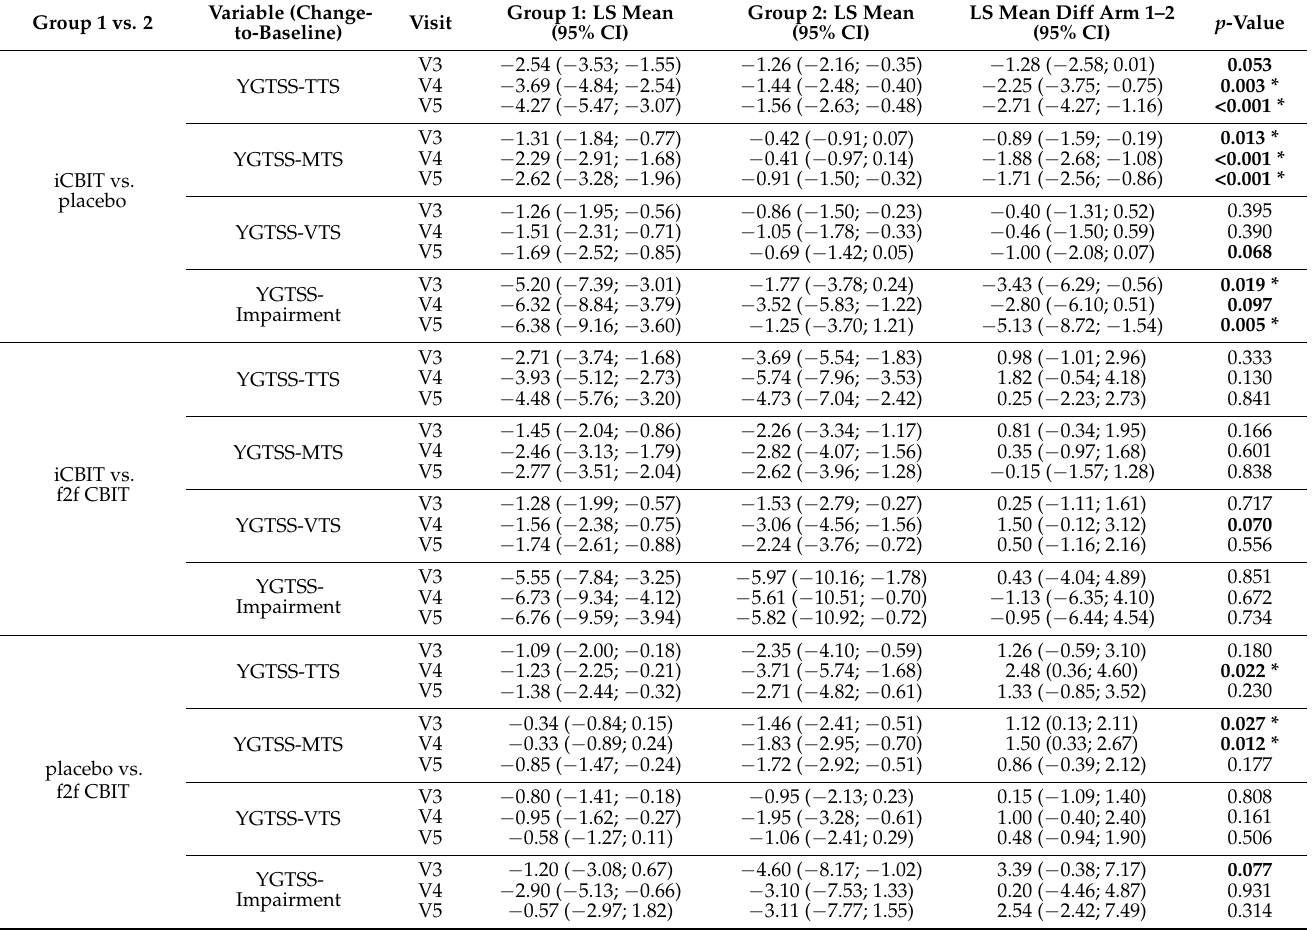
Table 3. Comparisons of YGTSS-TTS and YGTTS subscales between iCBT, placebo, and f2f CBIT at 1 week after end of treatment (V3, primary endpoint) and follow-up visits (V4, V5). Group 1 vs.